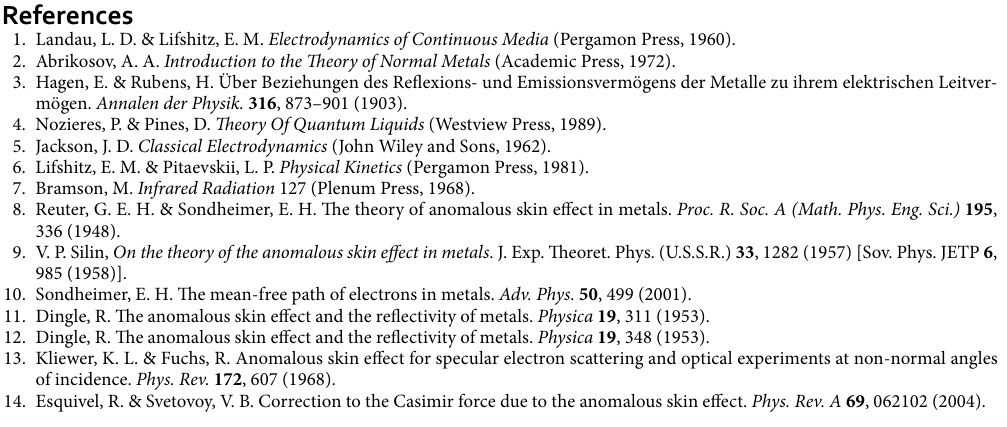
Figure 10. Ratio of absorptivities a 60 θ ◦ (b). Results for the full model in Eq. (20) (solid line ”Full”) are compared with the Drude approximation = (dashed line